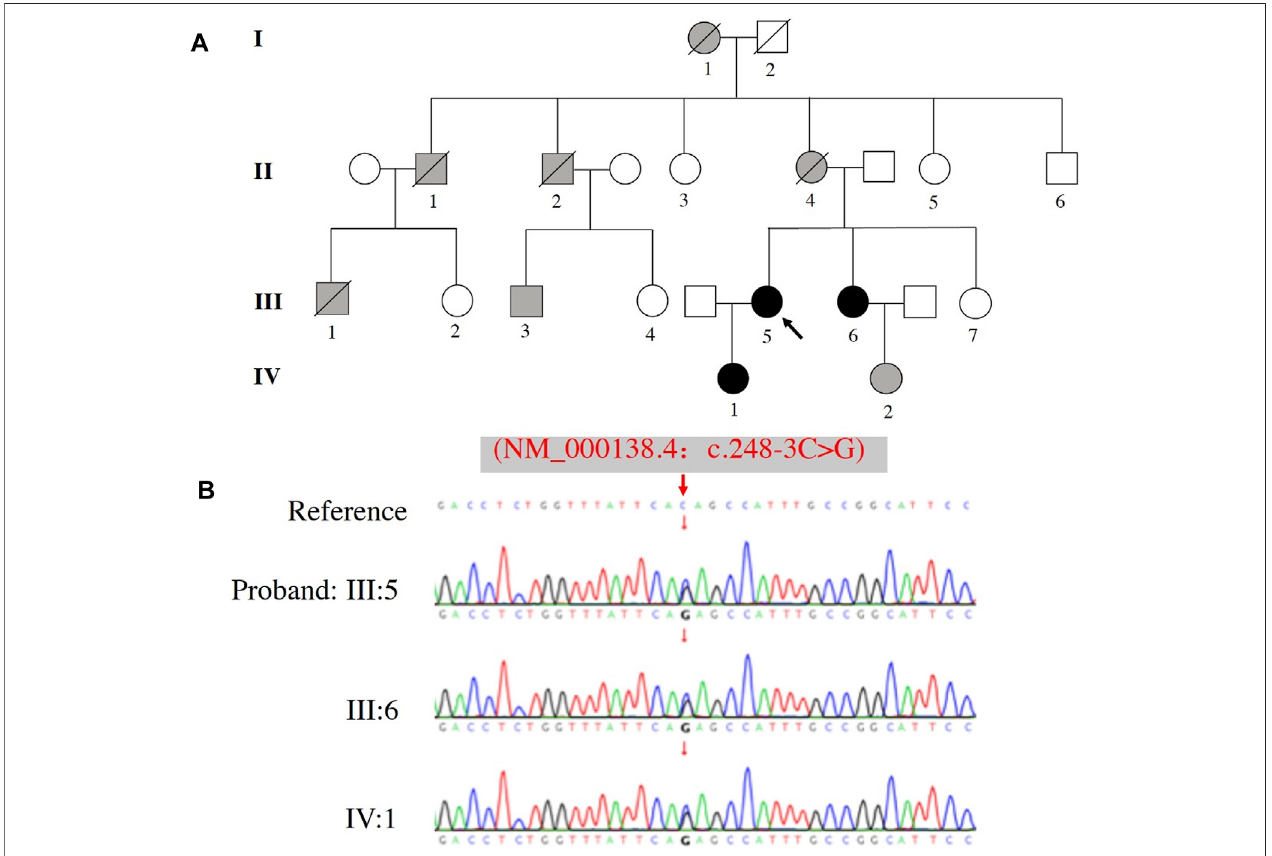
FIGURE2| PedigreeandsequenceanalysisofafamilywithahistoryofMFS. (A) Familypedigree,blackarrowindicatestheproband(III:5),blank fi llingindicatesnot affected, black fi lling indicates affected and genetically con fi rmed, gray fi lling indicates affected but not genetically tested. Lines through the shapes indicates deceased members. (B) The variant c.248-3C > G of FBN1 was identi fi ed in the proband (III: 5), her sister (III: 6), and daughter (IV: 1).